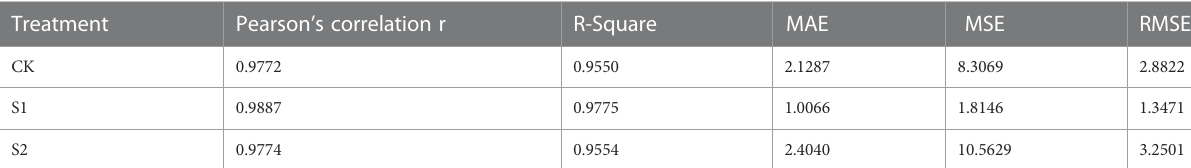
TABLE 4 Validation metrics used to compare manual counting and machine scoring.